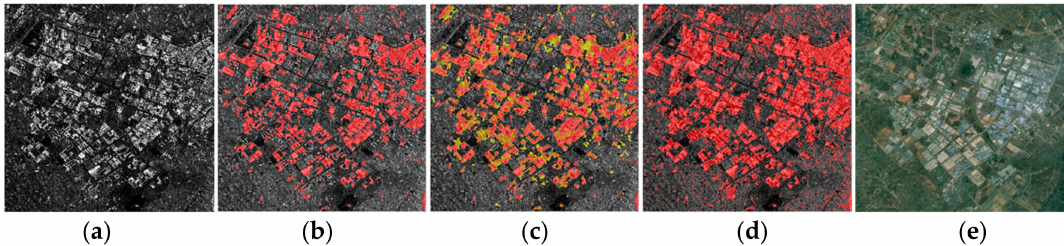
Figure 5. BAs results based on three methods. ( a ) SAR image; ( b ) BAs extraction result based on SSRG using intensity (Red: BAs); ( c ) BAs extraction result based on the proposed method (Red: BAs extracted using SSRG based on only intensity, Yellow: additional BAs extracted by adding Getis-Ord and Madogram); ( d ) BAs extraction result using the thresholding method (Red: BAs); ( e ) corresponding optical image from Google Earth